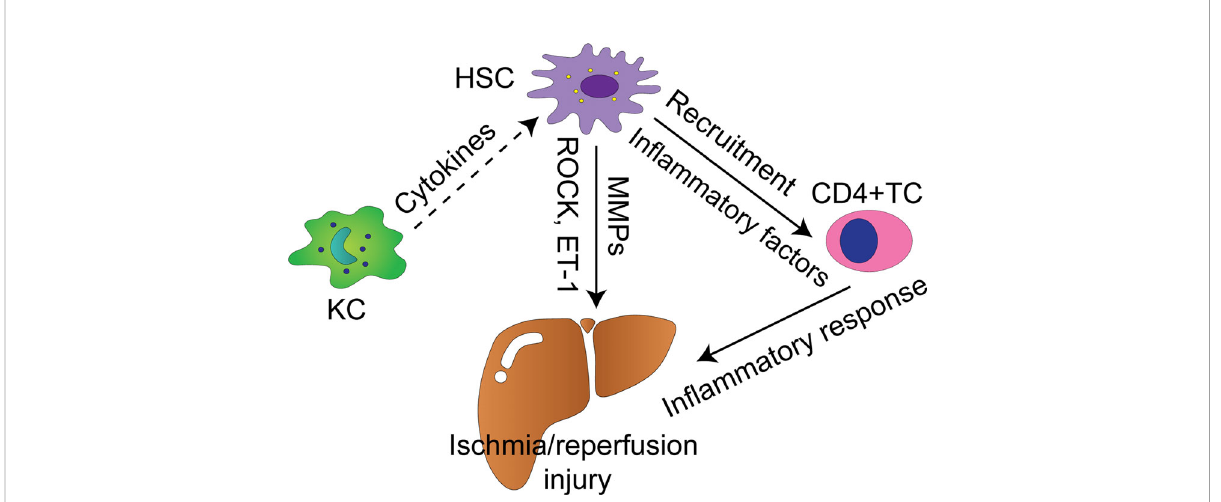
FIGURE 1 Cellular and molecular mechanisms by which HSCs modulate liver IRI. Solid arrows indicate positively regulatory effect with supporting experiment data, whereas dash arrows indicate putative positively regulatory effect. KC, Kupffer cell; TC, T cell; HSC, hepatic stellate cell; MMPs, matrix metalloproteinases; ROCK, Rho-associated coiled-coil forming protein serine/threonine kinase; ET-1,